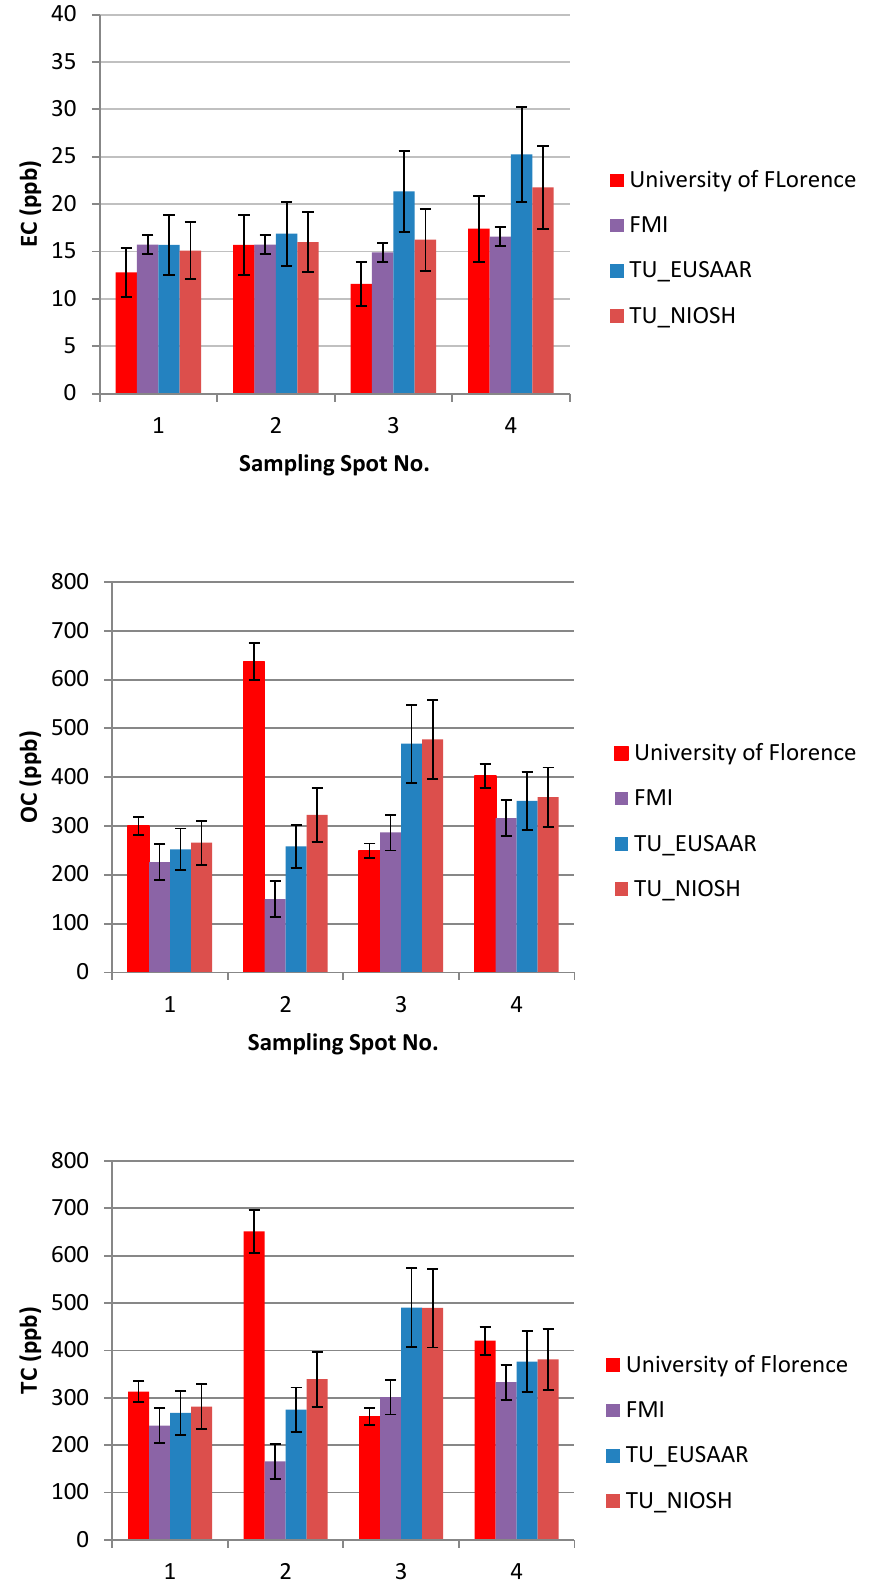
Figure 10. The results of the laboratory analysis from the three participating